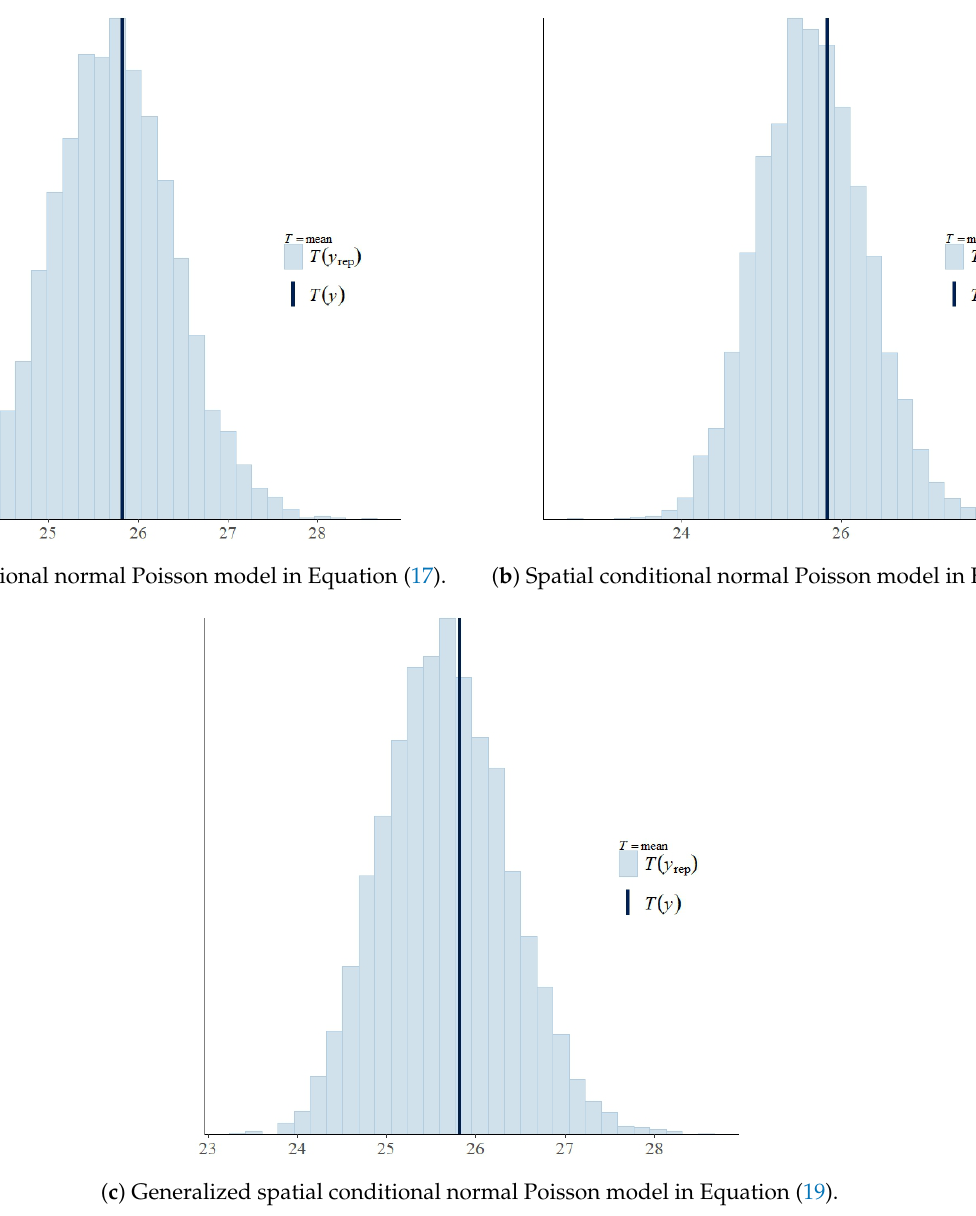
Figure 6. Posterior predictive checks for some of the fitted models to the Colombia infant mortality rates data